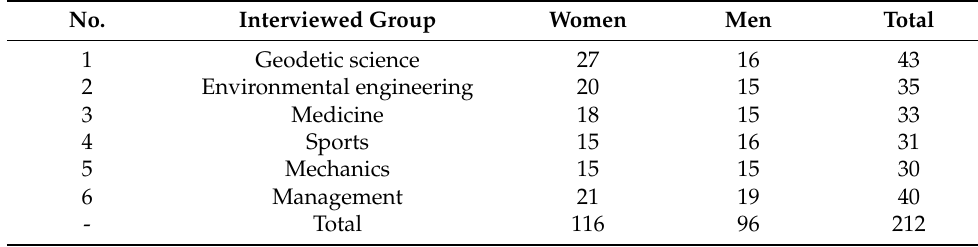
Table 2. Number of respondents in interviewed groups.